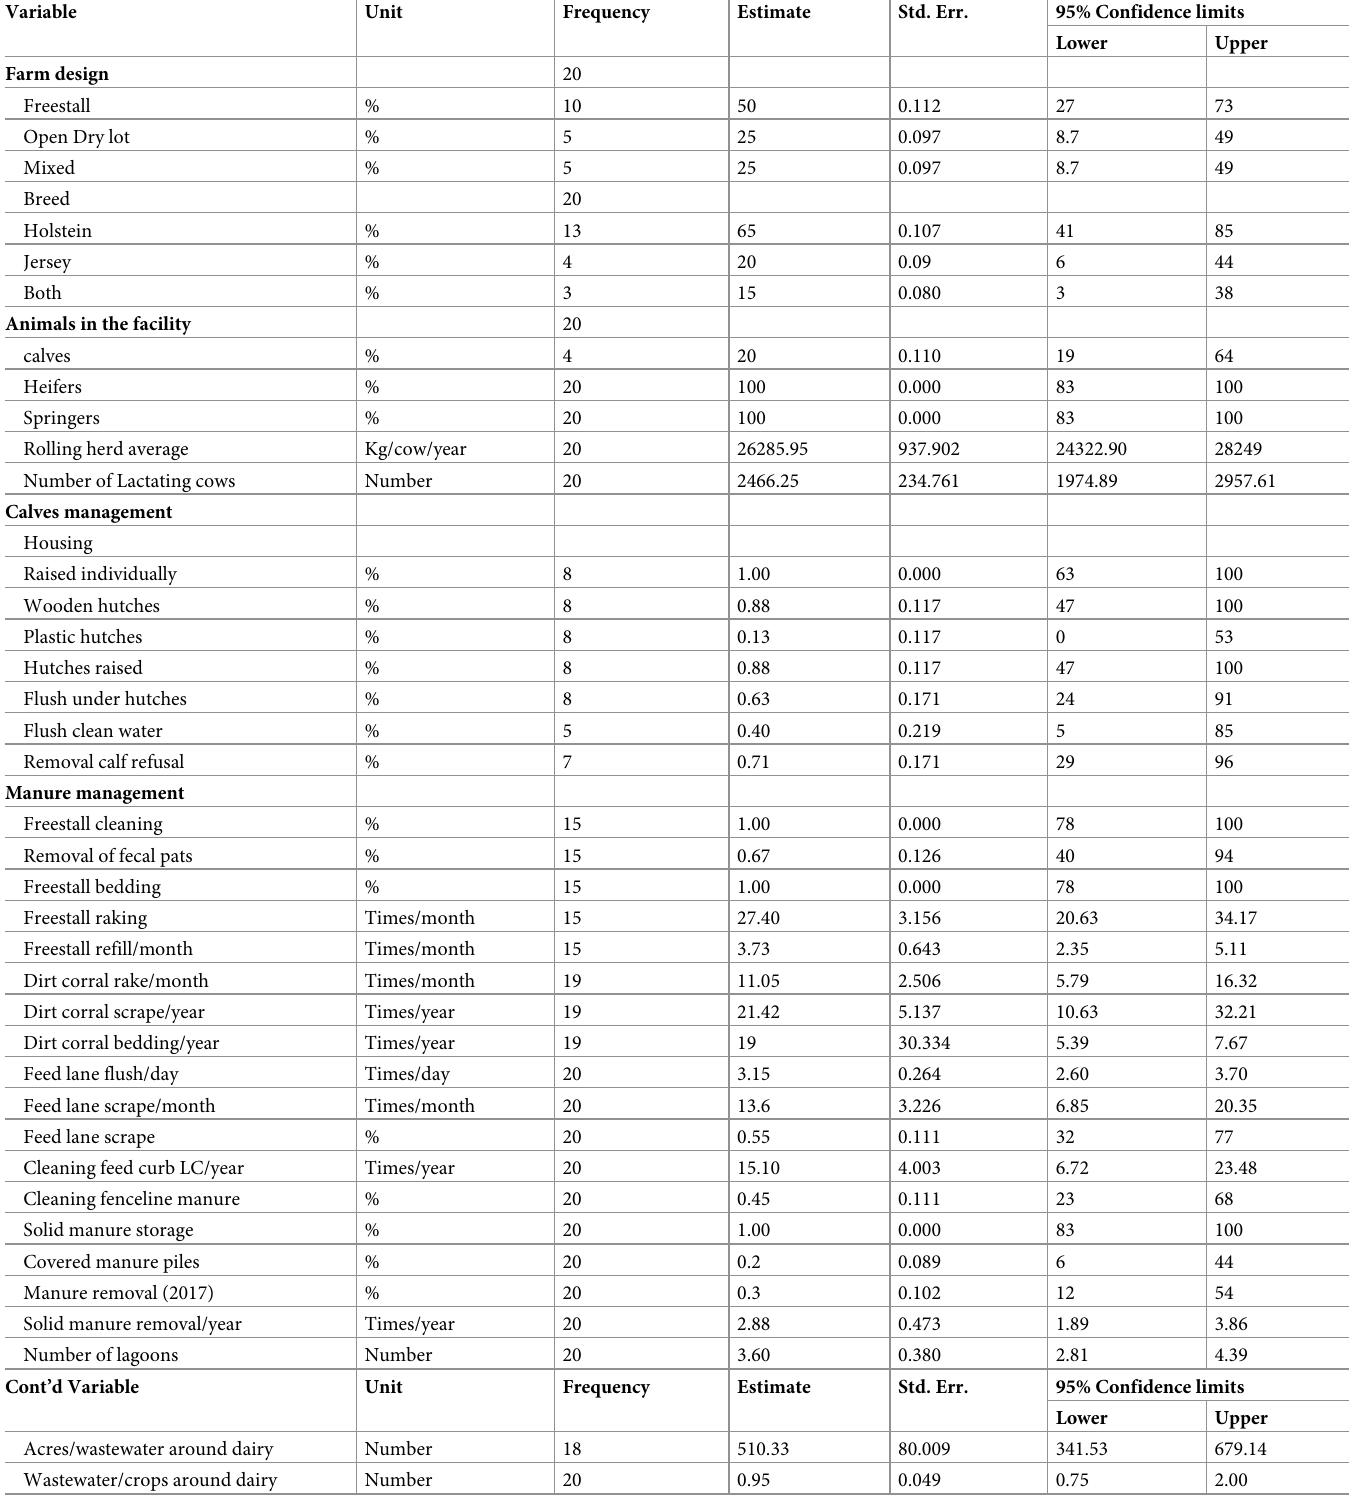
Table 1. Data description for the study